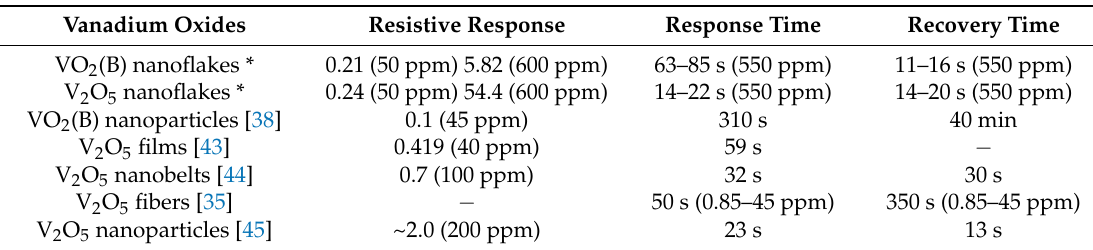
Figure 7. Dynamic responses for sensors of ( a ) VO 2 (B), and ( b ) V 2 O 5 nanoflakes. Dynamic switches are performed between air and 550 ppm ammonia. ( c , d ) High-magnification dynamic responses for one cycle, corresponding to VO 2 (B)- and V 2 O 5 -based sensors. Table 2. Comparison of various resistive sensor responses, response and recovery times to ammonia for VO 2 (B) and V 2 O 5 sensing systems.